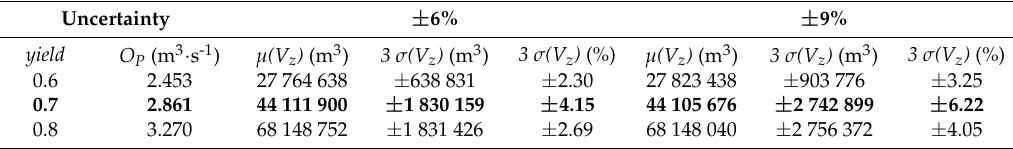
Table 1. Reservoir storage volume considering uncertainties for 100% reservoir